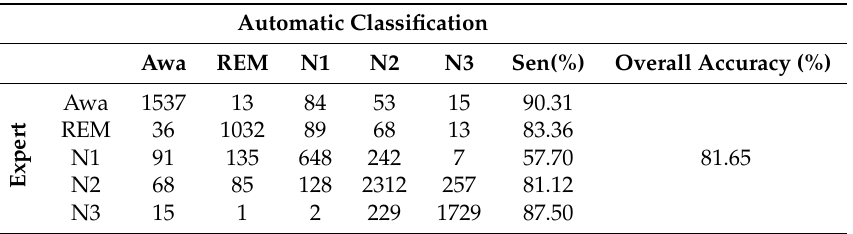
Table 29. The confusion matrix for five classes case on ISRUC3